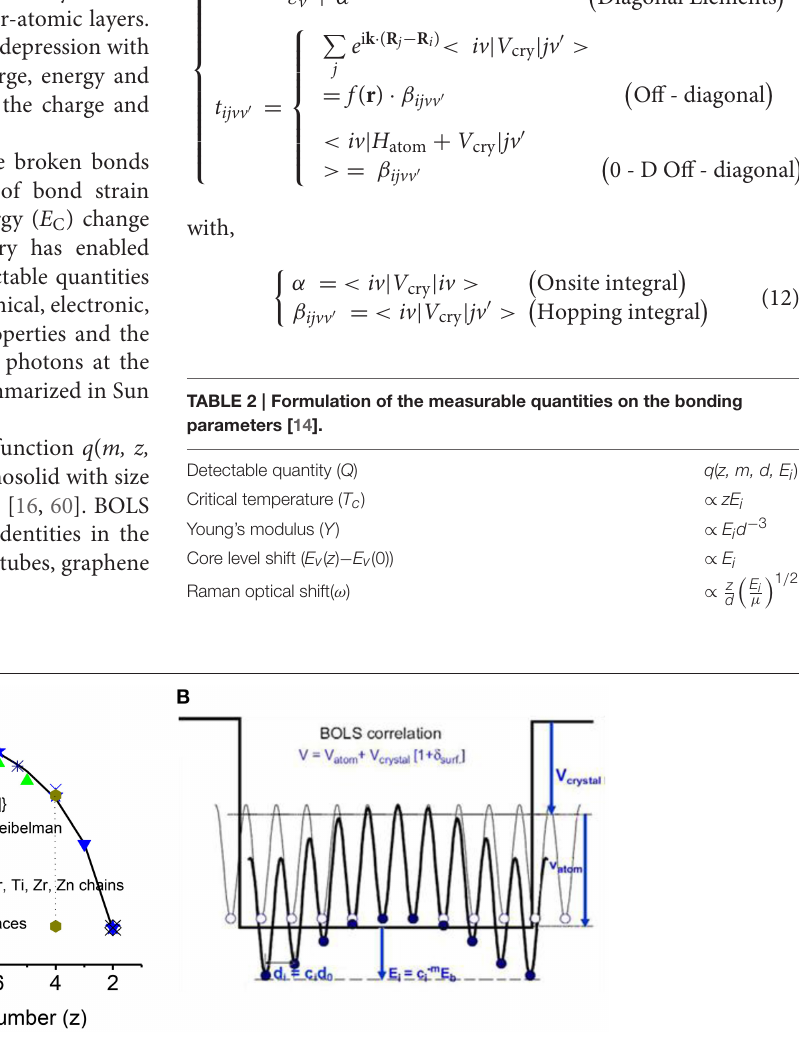
FIGURE 2 | (A) The BOLS correlation mechanism (solid line) formulated from the atomic “CN-radius.” The formulation has been further verified by the measurement (scattered symbols) from Au particles, carbon nanotubes, Pt, Ir, Ti, Zr, and Zn chains [14]. (B) Schematic illustration of the broken-bond induced potential trapping at the terminating edges up to two inter-atomic layers [58, 59]. Reprinted with permission of Sun [14].